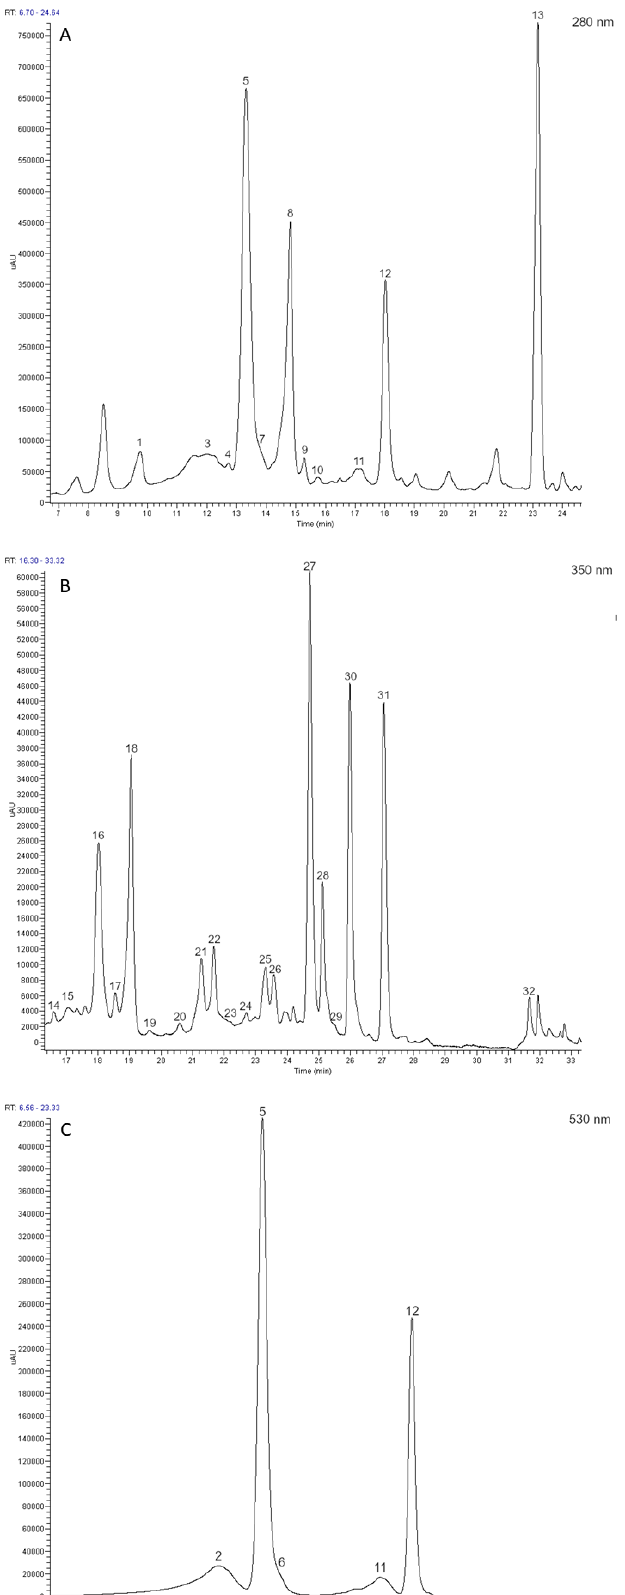
Figure 1. Phenolic chromatograms of strawberry fruit recorded at ( A ) 280 nm, ( B ) 350 nm and ( C ) 530 nm. Peak numbers are described in Table 3.